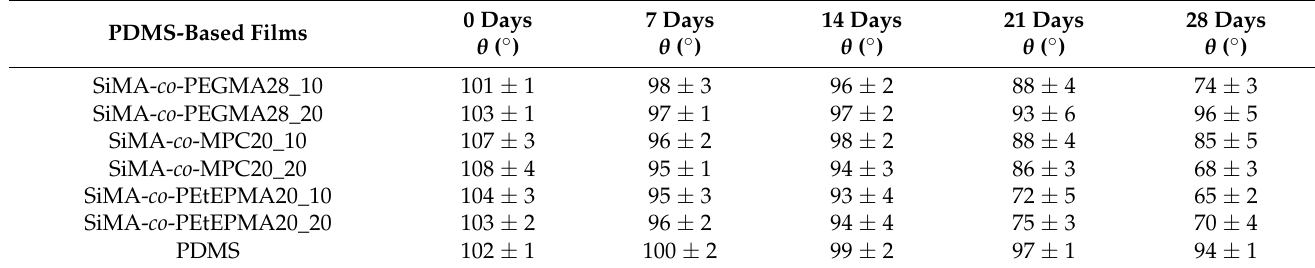
Table 4. Water contact angles of the three-layer PDMS-based